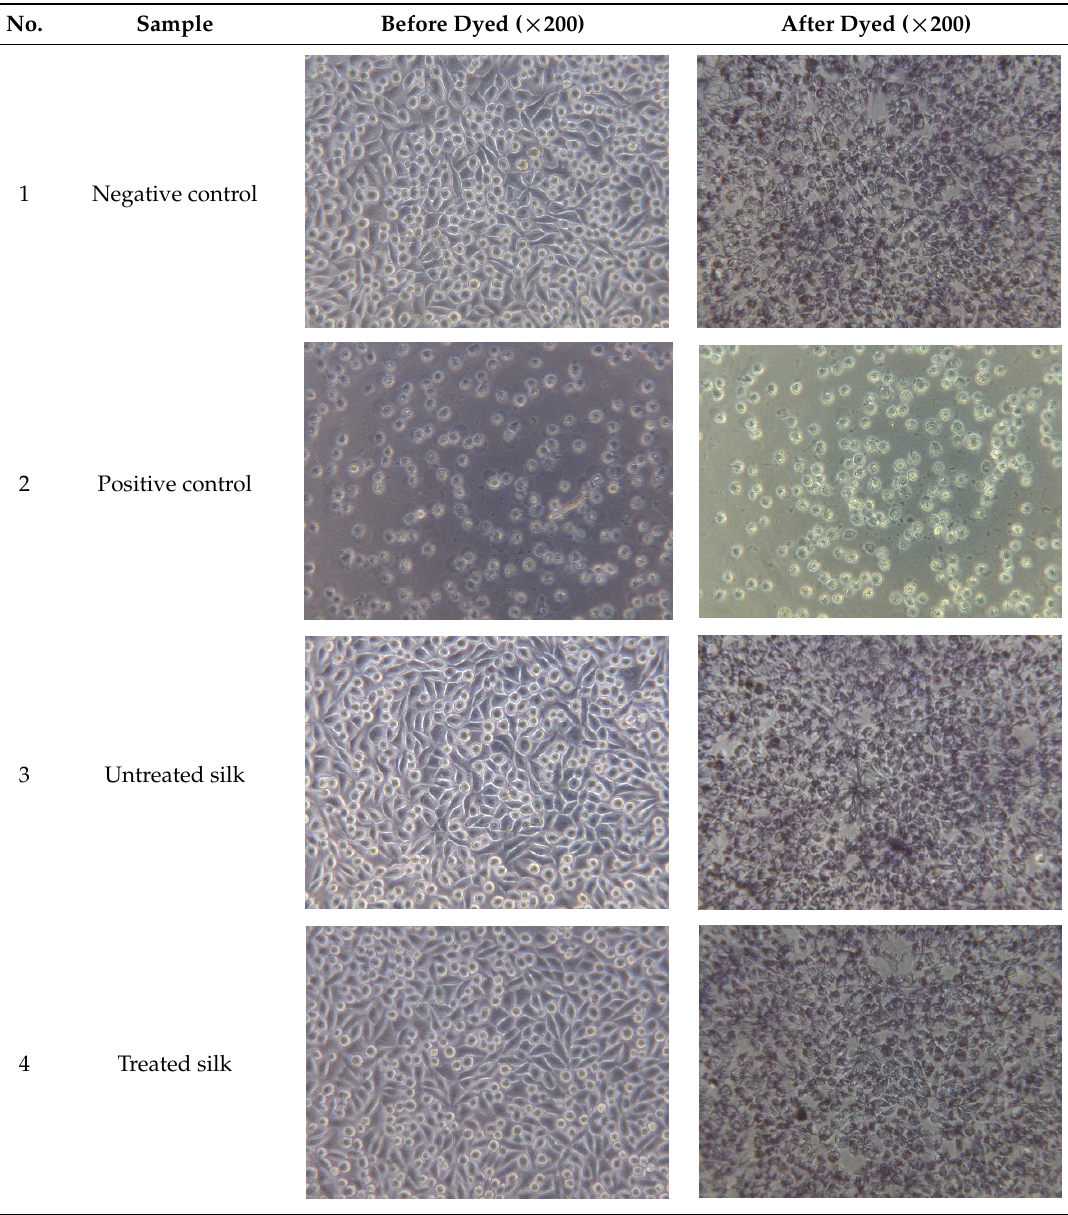
Table 8. Images of cytotoxicity testing of SS-AgNP finished silk.